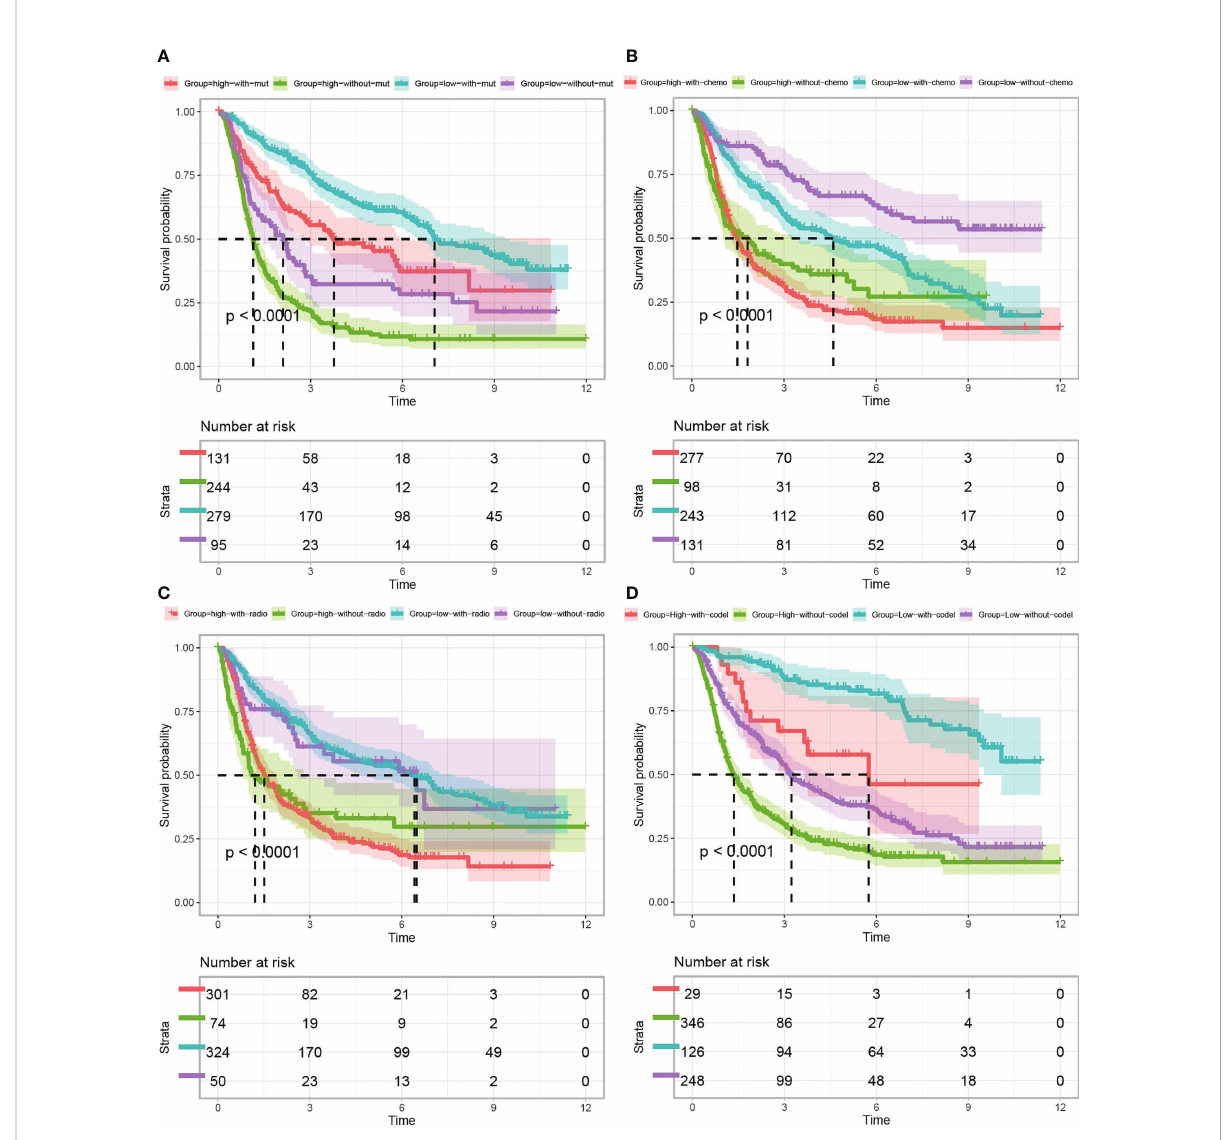
FIGURE 5 Kaplan – Meier curves of glioma patients (data obtained from CGGA) classi fi ed based on TP53I13 expression and (A) IDH mutation, (B) chemotherapy, (C) radiotherapy, and (D) 1p/19q codeletion